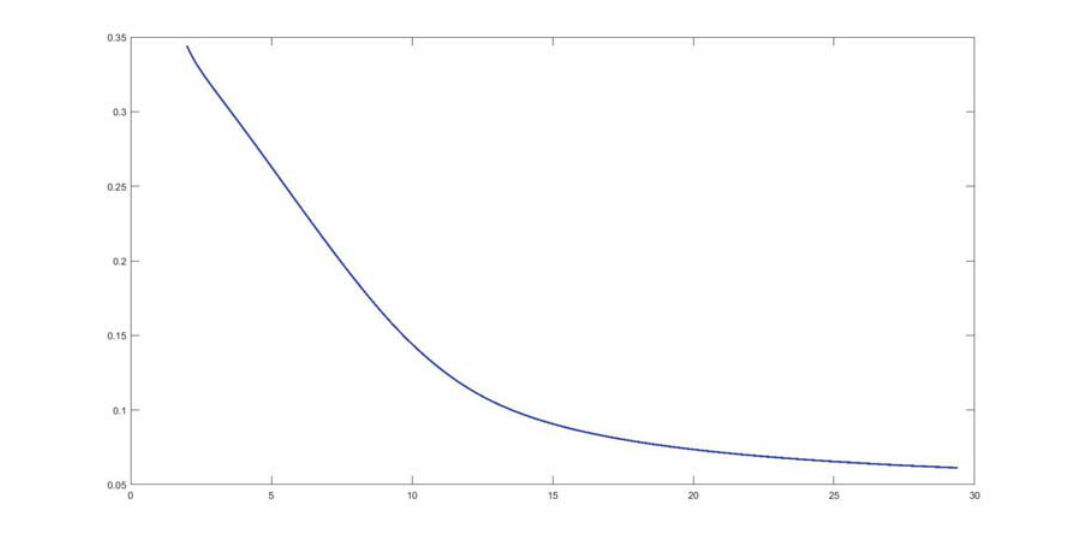
Fig. 19: Distance of the nodal line from the origin in case of the numerical solutions with two nodal regions and 3-symmetry